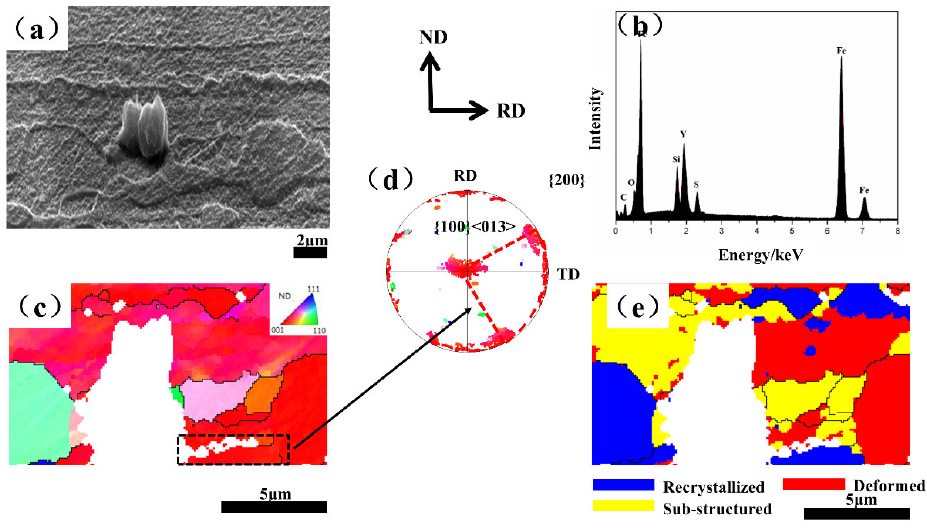
Figure 5. Recrystallization around a Y 2 O 2 S inclusion. ( a ) SEM micrograph; ( b ) EDS result; ( c ) IPF map; ( d ) {200} pole figure; and ( e ) recrystallization map.